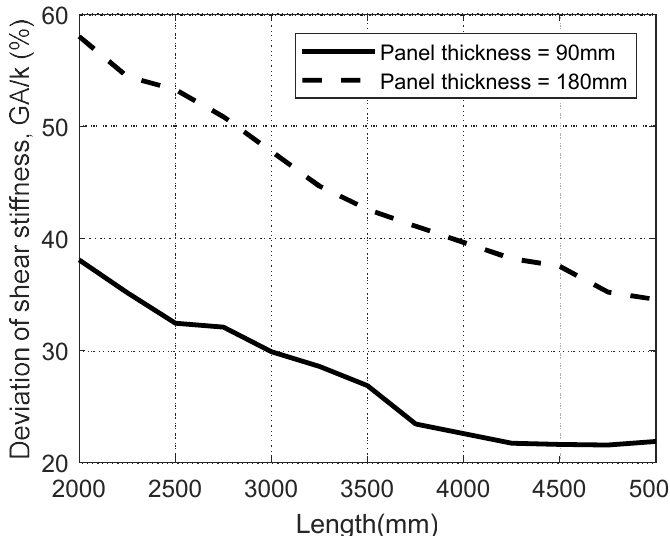
Figure 12. Deviation of shear stiffness of Timoshenko theory to that estimated from Numerical model for panel thickness of 90 mm and 180 mm where cross-layers are characterized by 250 MPa rolling shear modulus.